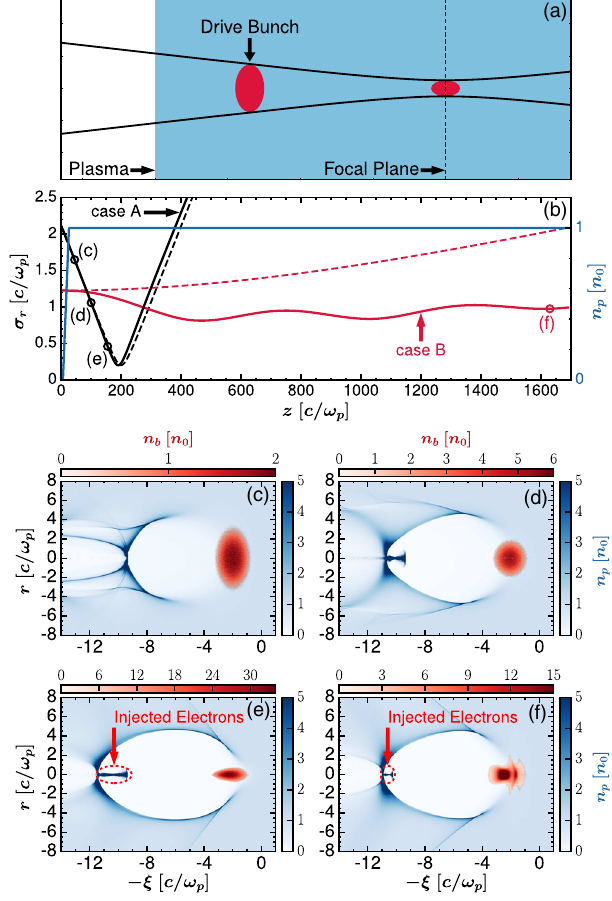
FIG. 1. (a) Schematic of self-injection in PWFA. Simulation results are shown in two regimes for electron drivers with Λ ¼ 6 focused into a plasma. (b) The projected spot size σ r of the driver is calculated from the simulation data (solid) and for vacuum propagation (dashed) for case A (black) and case B (red). The plasma density profile is shown in blue. The plasma wake is shown at propagation distances into the plasma of (c) z ¼ 45 c= ω z ¼ 100 c= ω z ¼ 155 c= ω p , (d) p , (e) p for case A and (f) z ¼ 1630 c= ω p for case